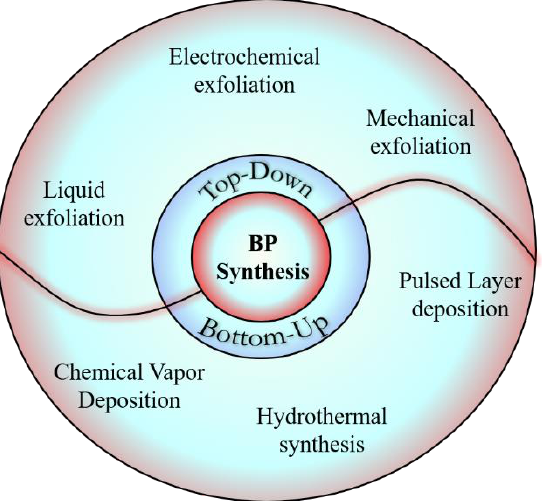
Figure 1. Schematic representation of various synthesis strategies for fabricating two-dimensional (2D) materials.